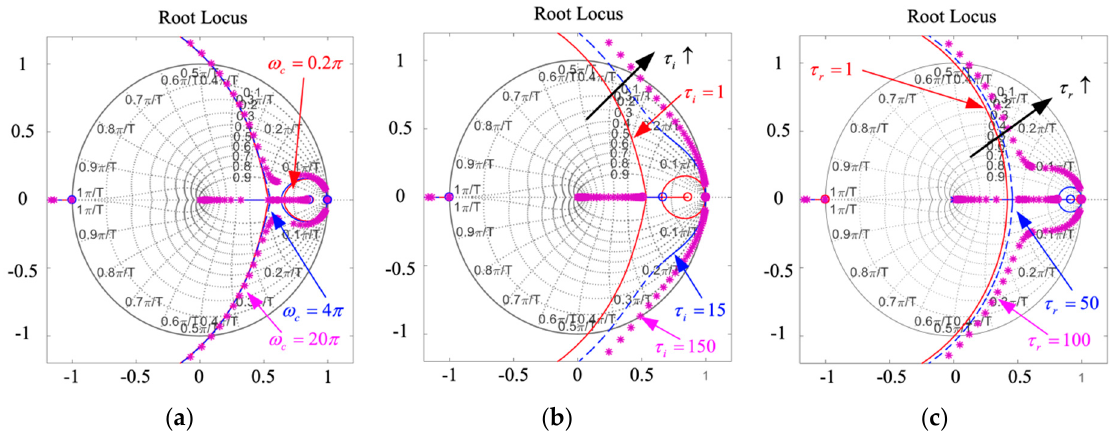
Figure 12. Root locus of the estimator based on PIR controller. ( a ) ω c ; ( b ) τ i ; ( c ) τ r .